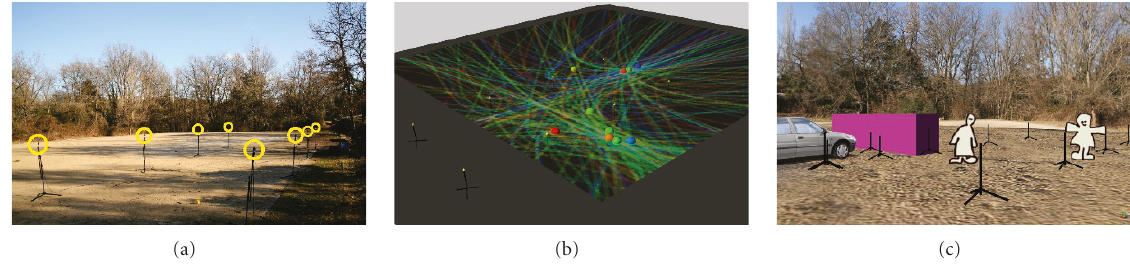
Figure 1: (a) We use multiple arbitrarily positioned microphones (circled in yellow) to simultaneously record real-world auditory environ- ments. (b) We analyze the recordings to extract the positions of various sound components through time. (c) This high-level representation allows for postediting and rerendering the acquired soundscape within generic 3D-audio rendering